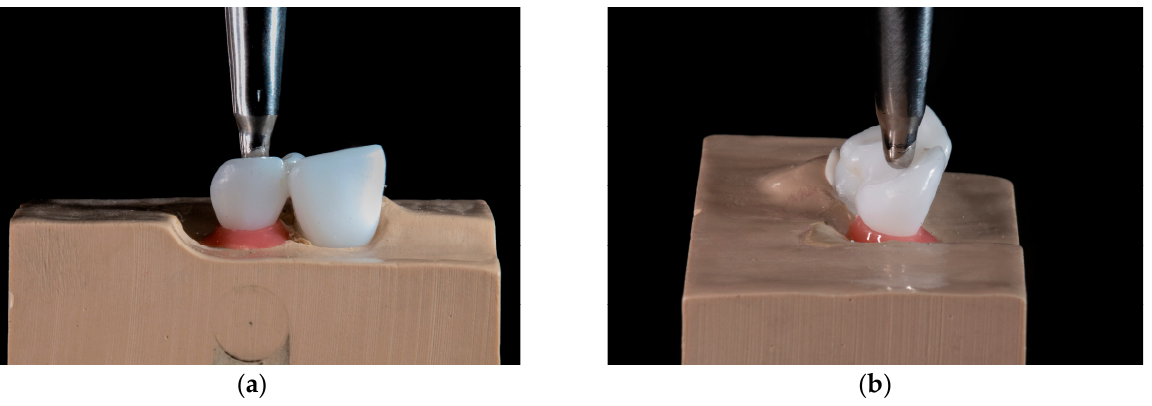
Figure 2. Cyclic loading. The load was transferred through a steel cylinder ball, positioned palatally. ( a ) Frontal view; ( b ) lateral view.